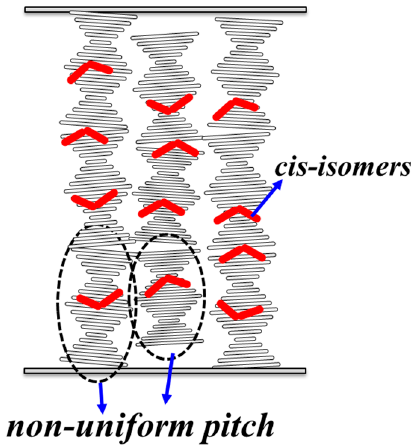
Figure 5. Schematic diagram of CAdLCs (chiral-azobenzene-doped liquid crystals) with a planar texture (helix axis normal to the substrates) that were disturbed by the bent-shaped cis -isomers after UV illumination for a long period of time. Moreover, the local pitch could be nonuniform due to variations in the cell thickness and nonuniform alignment layers.